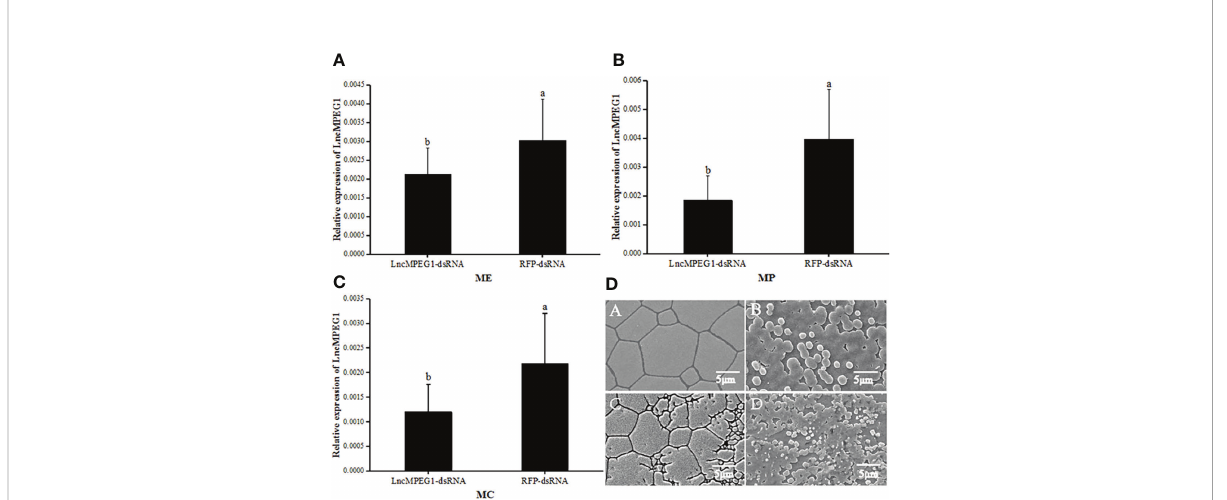
FIGURE 5 The expression level of LncMPEG1 in the mantle tissue (A – C) and the ultrastructure of the inner surface of the shell (D) after RNAi. The negative control group: red fl uorescent protein (RFP); The experimental group: LncMPEG1 -dsRNA,; ME, mantle edge; MP, mantle pallial; and MC, mantle center; the mean values with different letters indicate signi fi cant difference (P < 0.05); A – C the prismatic layer of the control and experiment group, respectively; B – D , the nacreous layer of the control and experimental group, respectively.